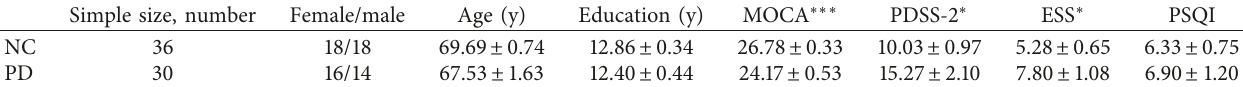
Table 2: Comparisons of MOCA, PDSS-2, and ESS scores between NC and PD groups. Simple size,